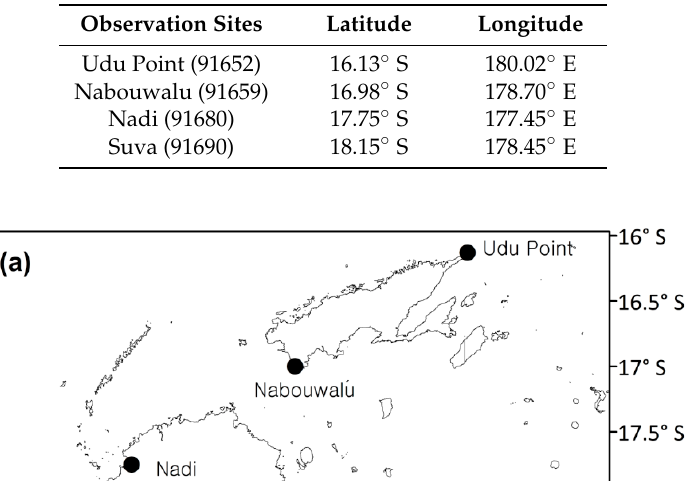
Table 1. Fiji rainfall gauges used in the analysis.